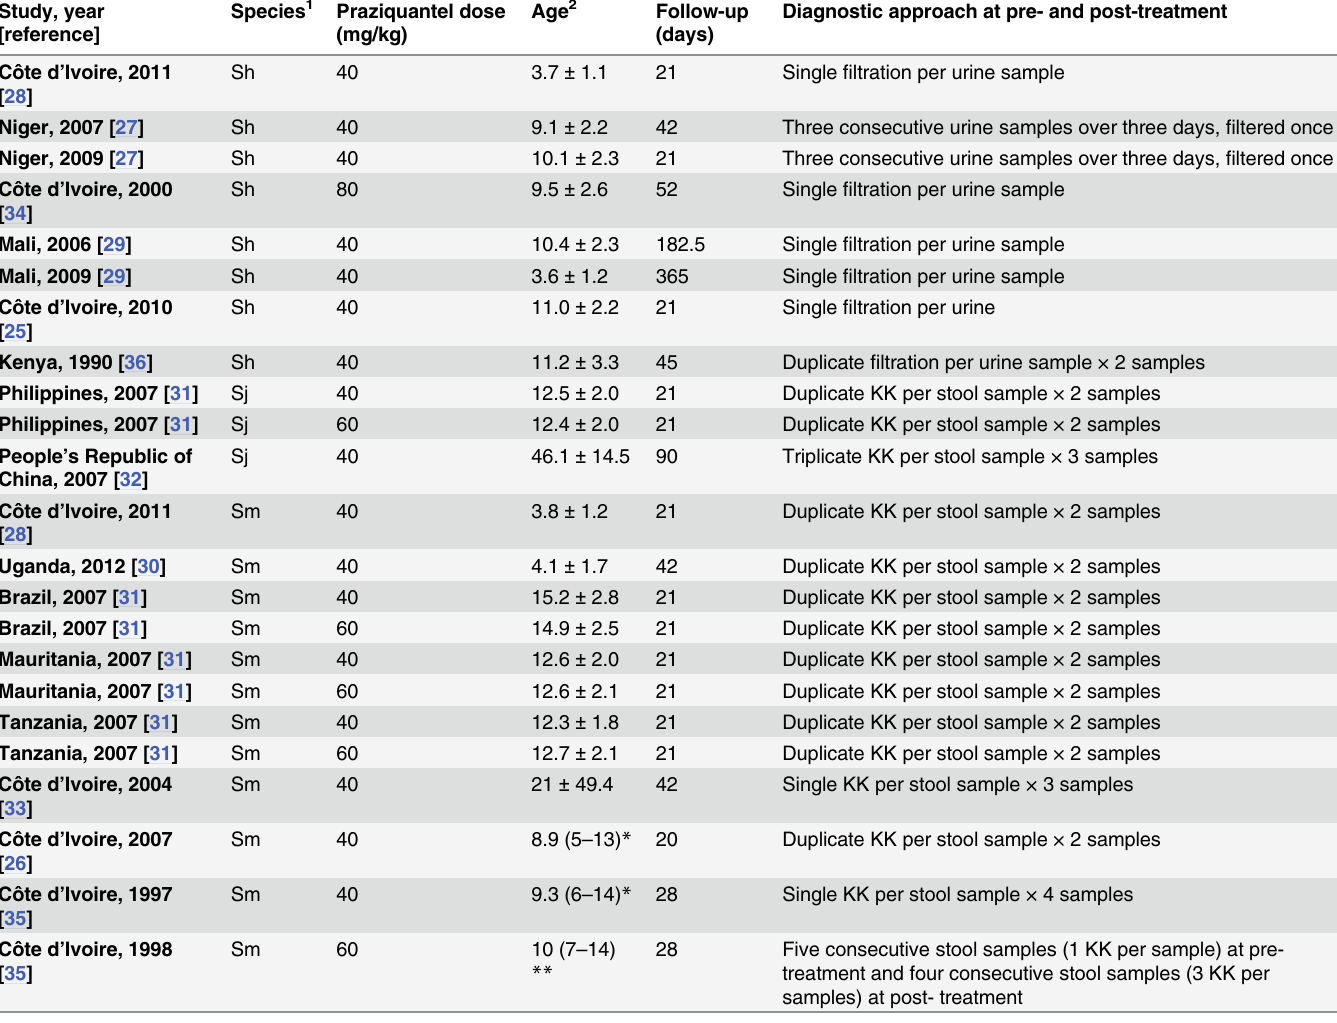
Table 1. Study and individuals ’ main